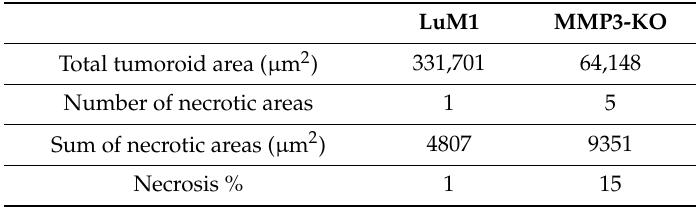
Figure 11. MMP3-knockout resulted in necrotic cell death in tumoroids. Tumoroids were cultured in the ULA-based 3D culture system with a stemness-enhancing medium for 8 days. ( A , B ) Hematoxylin and eosin (H&E) staining of ( A ) LuM1- and ( B ) MMP3-KO tumoroids. Necrotic areas were enclosed with black color, while the total tumoroids area was enclosed with yellow color. Scale bars, 50 μ m. ( C ) The percentage of the necrotic areas in both tumoroids. Table 2. Necrotic areas in the LuM1 tumoroid versus MMP3-KO tumoroid.